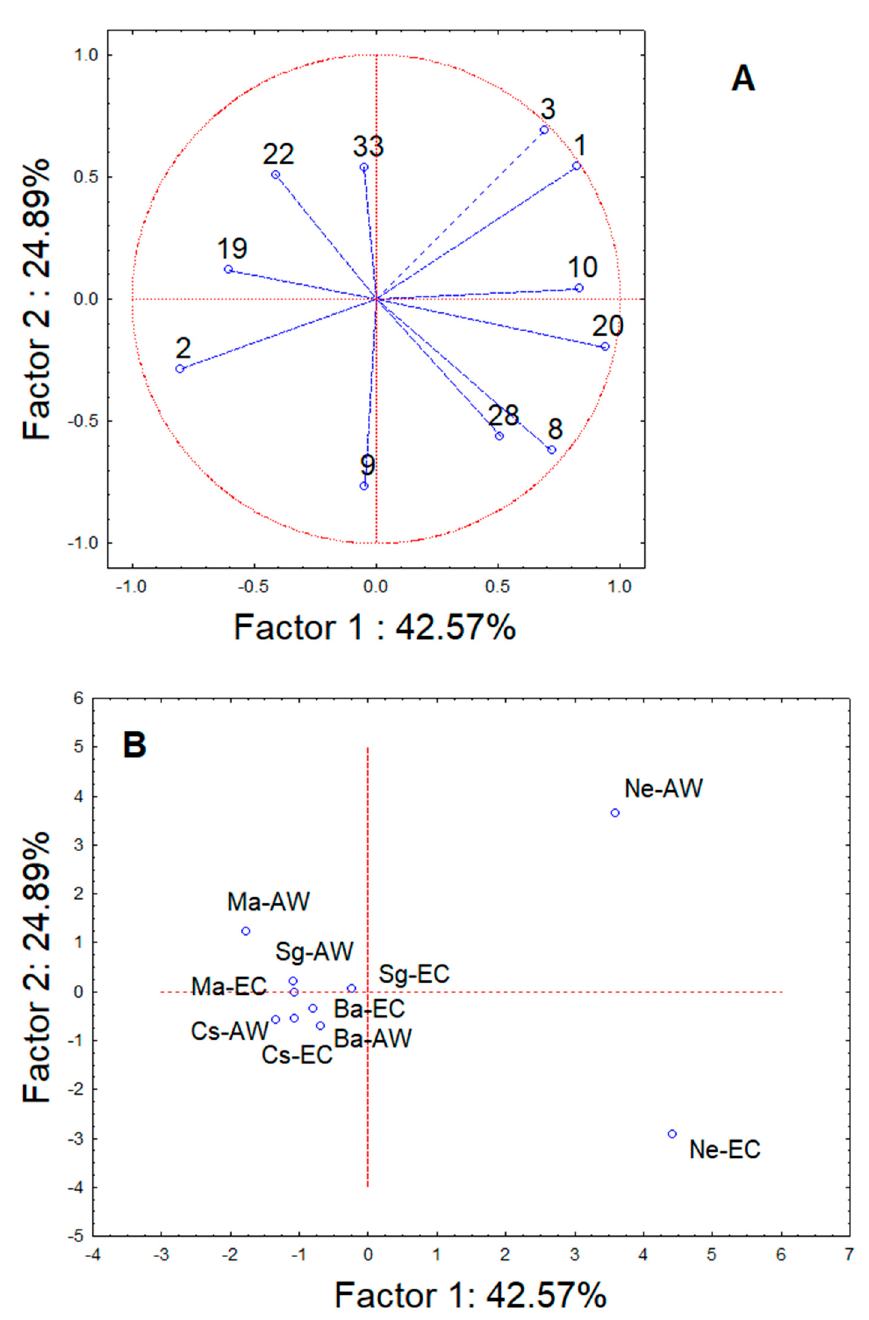
Figure 8. Principal component analysis run on some selected esters. ( A ) Variable projection; ( B ) case projection. Sg, Sangiovese; Ma, Magliocco; Ba, Barbera; Cs, Cabernet-Sauvignon; Ne, Negroamaro.